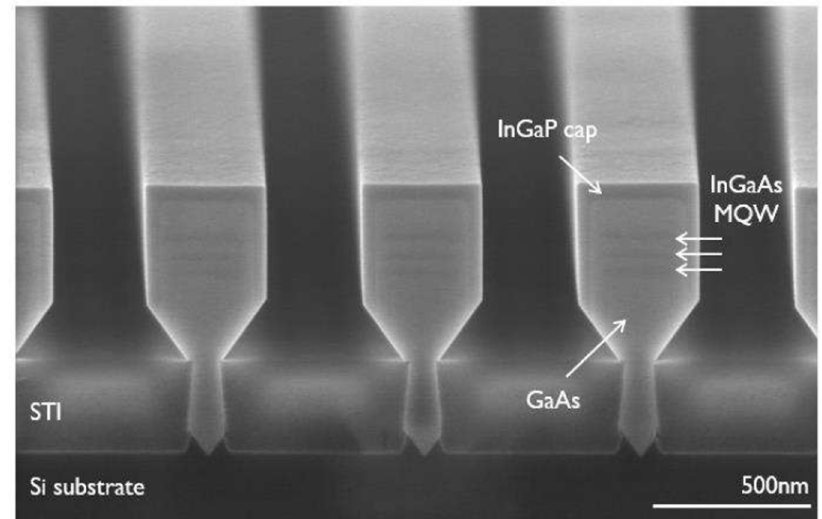
Figure 15. SEM image of the InGaAs/GaAs MQWs in box-shaped GaAs nano ridge structure; the InGaP cap layer was easily observed by the darker contrast. The three MQWs were slightly lighter in color. Reprinted with permission from ref. [72] © IOP Publishing. Copyright 2016 ECS Transactions.